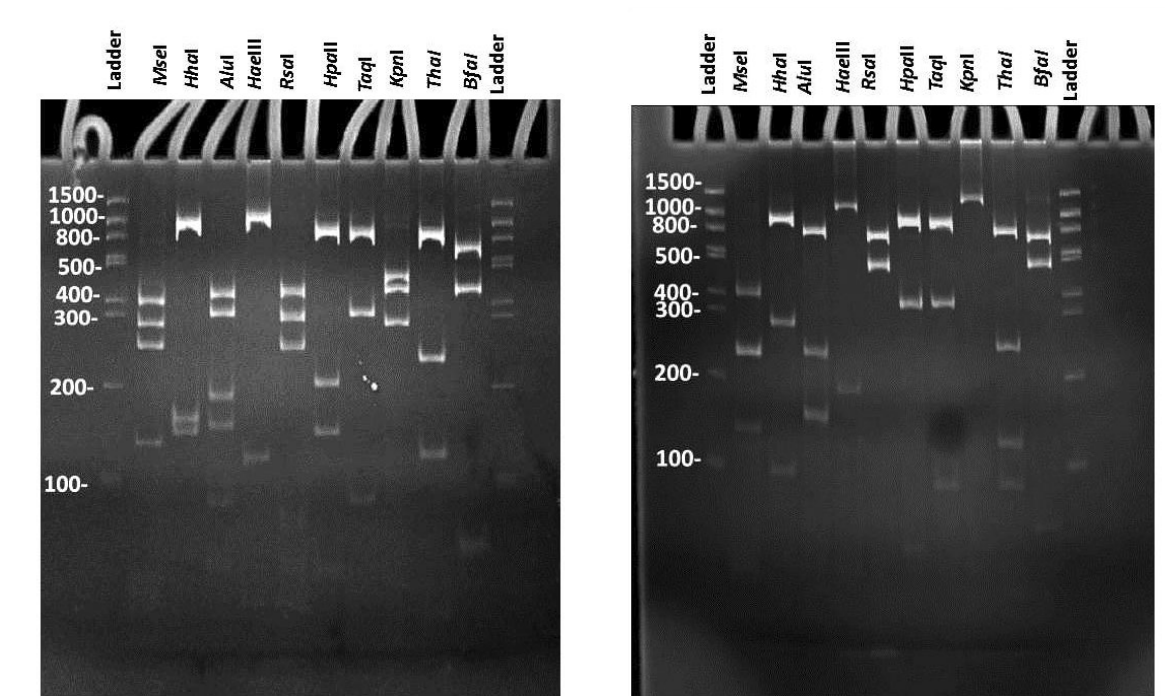
Figure 2. Polyacrylamide gel showing RFLP profiles of 16S rDNA amplified by nested PCR using P1/P7 followed by R16F2n/R16R2 primer pairs from (left) yellowing and (right) witches’ broom symptomatic jujube plants. PCR products were digested by the enzymes indicated at the top of the figures; Ladder, 100 bp DNA ladder (Biobasic, Canada).